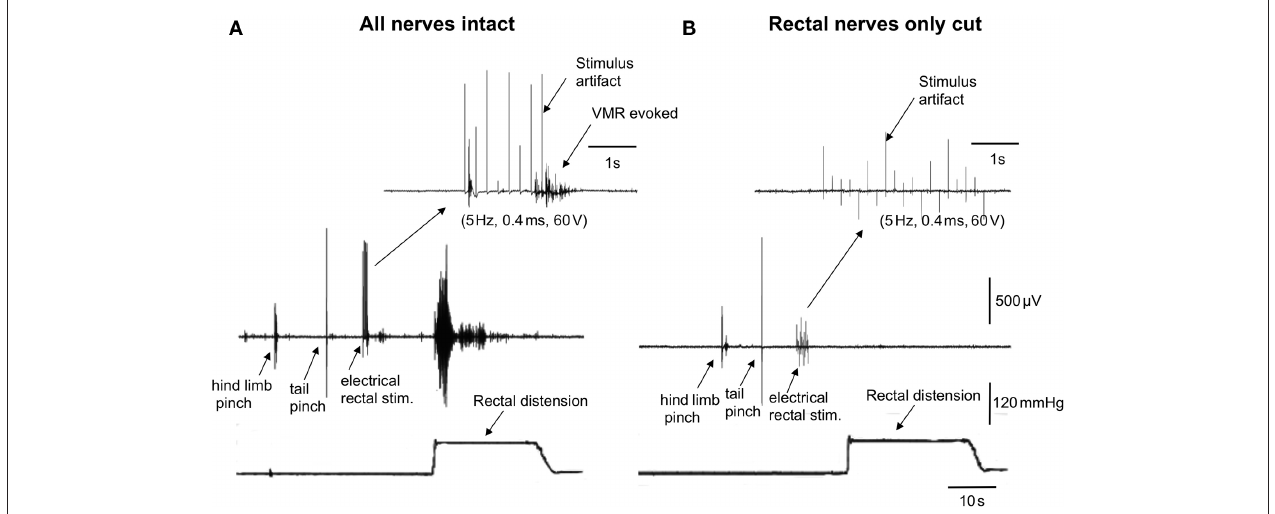
all elicited VMRs. (B) Lesions applied only to the left and right branches to the rectal nerves abolished VMRs to acute noxious colorectal distension and electrical stimulation of the rectum, but not those evoked by hind limb pinch or tail